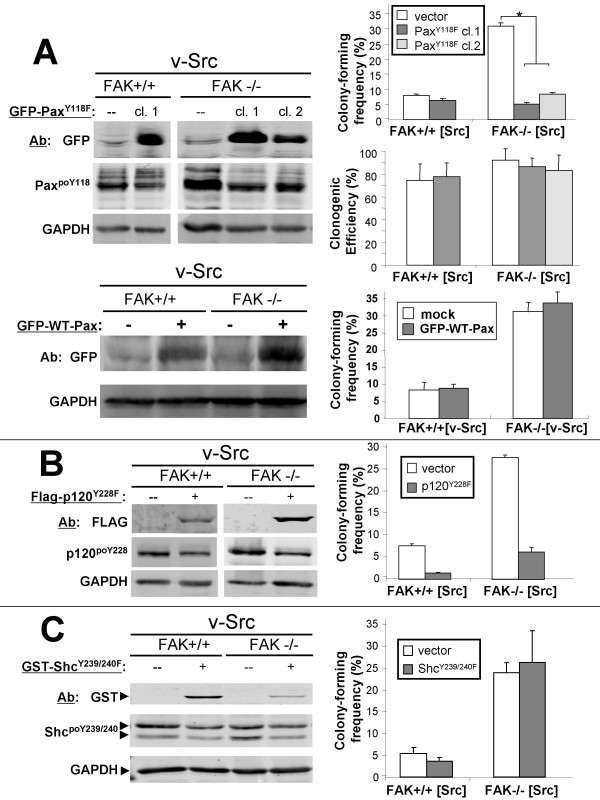
Phosphorylation of paxillinpoY118 is required for enhanced AIG by FAK-/-[v-Src] cells. (A) Left panel- IB analysis of FAK+/+[v-Src] or FAK-/-[v-Src] cell clones ("cl.") stably transfected with empty vector (--) or a GFP-paxillinY118F-expressing vector, probed with Abs specific for GFP, paxillinpoY118 or GAPDH. Aliquots of these cells were analyzed by anchorage-independent growth (top right) or for clonogenic efficiency (bottom right) as described in Materials and Methods. Error bars, S.E. *, P < 0.01. (B) A similar analysis as in panel A except on cells stably expressing FLAG-p120Y228F, with IBs probed for FLAG, p120cateninpoY228 or GAPDH. Note that there is no statistical difference in the p120cateninY228F-mediated decrease in AIG between the FAK+/+[v-Src] and FAK-/-[v-Src] cells. (C) A similar analysis as in panel A except on cells stably expressing GST-ShcY239/240F, with IBs probed for GST-tag, ShcpoY239/240, or GAPDH.